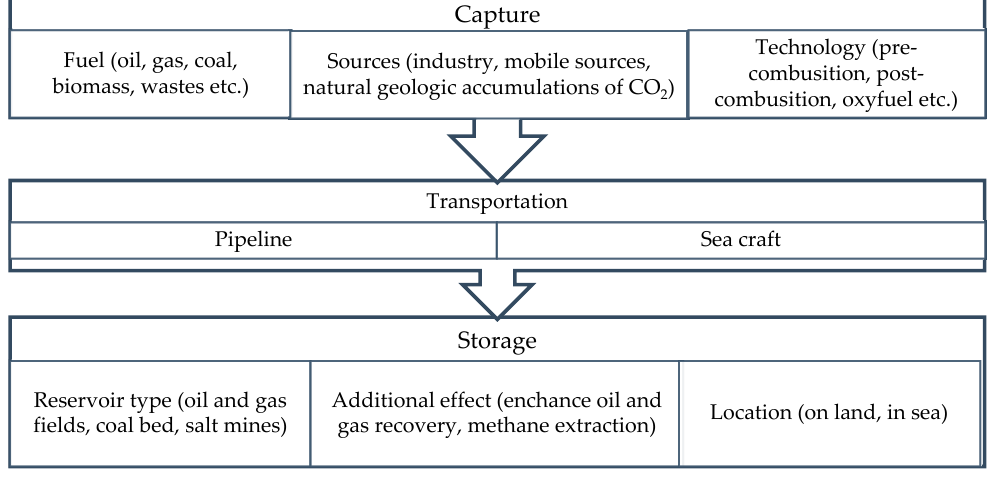
Figure 2. Scheme of CCS technology [41].